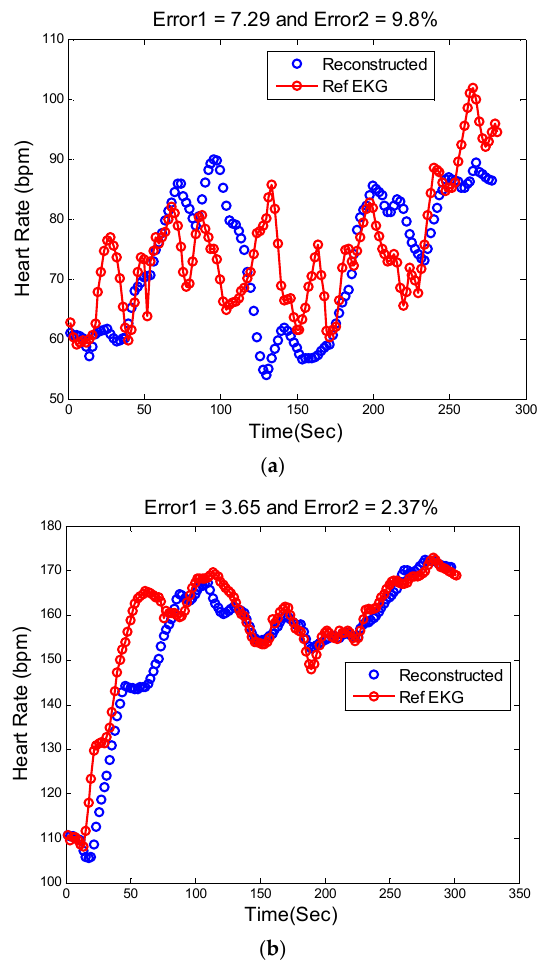
Figure 9. Reconstructed HR vs. reference HR: ( a ) Subject 14 (IEEE Competition Test Dataset); ( b ) Subject 16 (IEEE Competition Test Dataset).